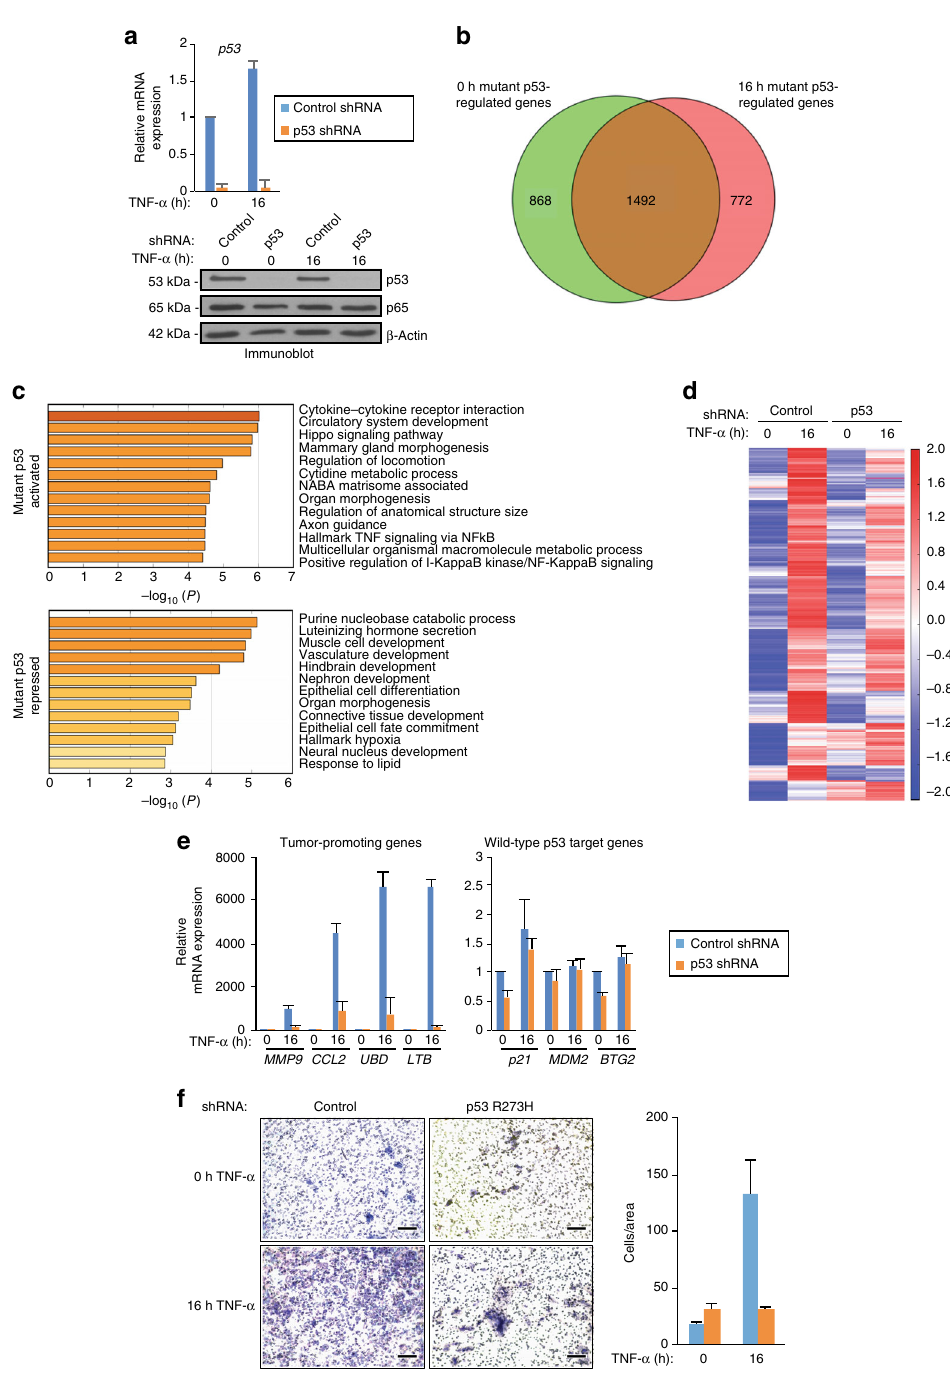
Fig. 1 Mutp53 regulates chronic TNF- α induction of protumorgenic genes. a qRT-PCR (top) and immunoblot (bottom) analyses of SW480 cells induced to express LacZ (control) or p53 (p53) shRNA and treated with TNF- α for 0 or 16 h. The expression levels following TNF- α treatment are relative to the levels before TNF- α exposure. The bar graph represents the average of three independent experiments with the error bars denoting the standard error. b Venn diagram depicting the number of genes affected by mutp53 depletion in SW480 cells treated as described in ( a ). Genes were sorted prior to (green, 0 h) or after (pink, 16 h) TNF- α treatment (FDR < 0.05). c Gene Ontology analysis using Metascape of the 772 mutp53-regulated genes upon 16 h TNF- α treatment, corresponding to the pink only portion of the Venn diagram in ( b ). d Heat map of the differentially expressed RefSeq genes induced by twofold or higher (FDR < 0.05) after TNF- α induction in the control relative to the mutp53 knockdown cells. e qRT-PCR analyses of mutp53 target genes (left) and known wild-type p53 target genes (right) in control and p53 shRNA SW480 cells that were treated with TNF- α for 0 or 16 h. The expression levels shown after TNF- α are relative to the levels before treatment. The bar graph represents the average of three independent experiments with the error bars denoting the standard error. f Representative images (left) and quantitation (right) of invasion assays performed with SW480 cells treated as described in ( a ) that were fi xed and detected by Giemsa staining (scale bar: 0.2 mm). The bar graph represents the average number of cells invaded through the Matrigel- coated membrane from three independent experiments with the error bars denoting the standard